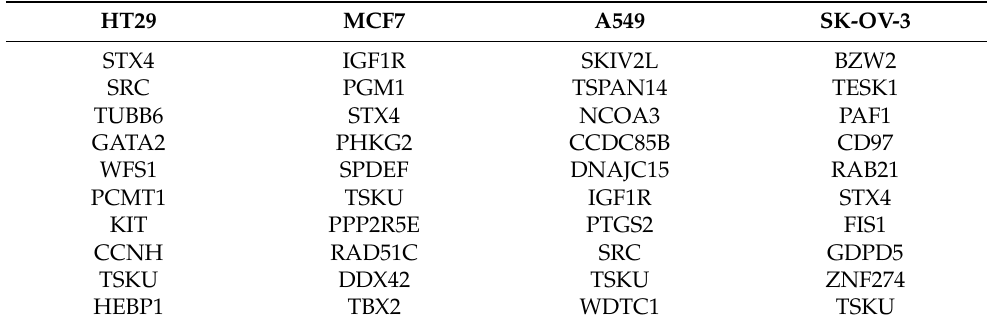
Table 3. The top 10 key genes in four cancer cell